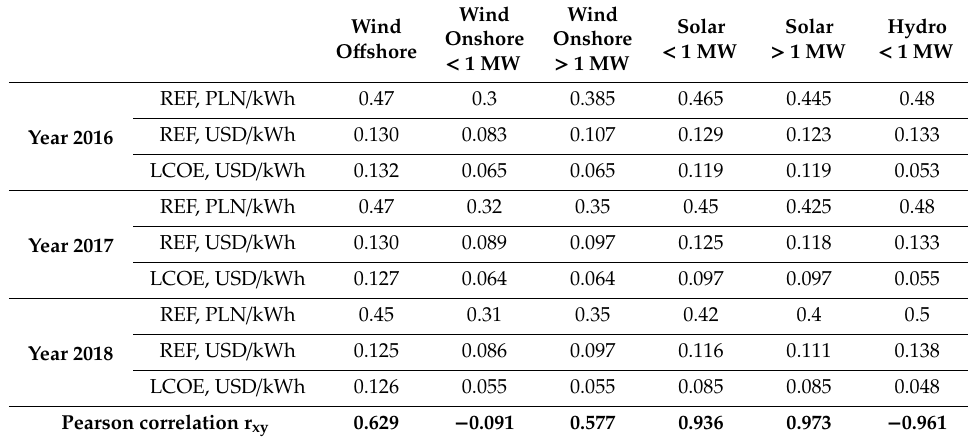
Table 11. LCOE values (based on [45]) and reference prices (REF) at Polish RES auctions in 2016–2018, expressed in USD 2018 / kWh.